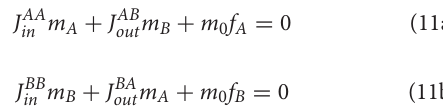
FIGURE 3 | the large-network limit. Parameters are chosen such that the theoretical mean activity is identical for all three population types. (B) Histogram of the spike count Fano factors across neurons in the two-population network. (C) Histogram of the spike count Fano factors across neurons in the one-population network. Parameters in the one-population network utilized are J E 1, J I 1.8, N 20,000, f E 0.8, K 800, and θ 1. Parameters in the two-population network utilized = = = = = = J IE are J EE 1, J II 1.8, J EI 2, N E 10,000, N I 10,000, f E 1, f I 0.8, m 0 0.1, K 800, θ E 1, and θ I = = = − = − = = = = = = = =